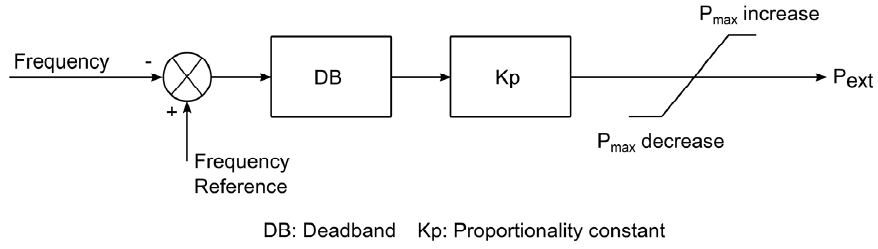
Figure 7. Basic inertia emulation model block diagram.